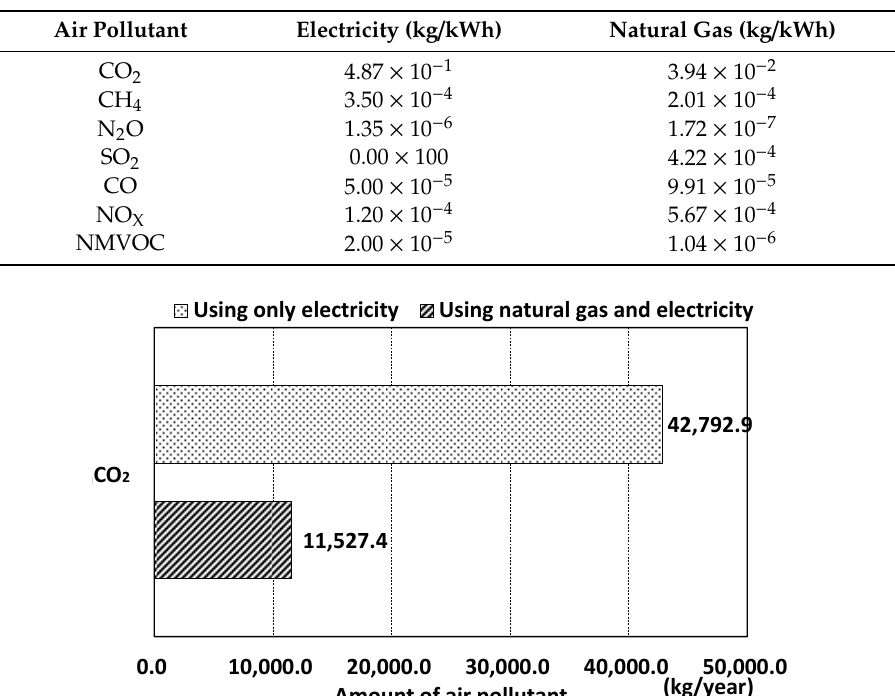
Table 4. Air pollutant emission densities of electricity and natural gas.